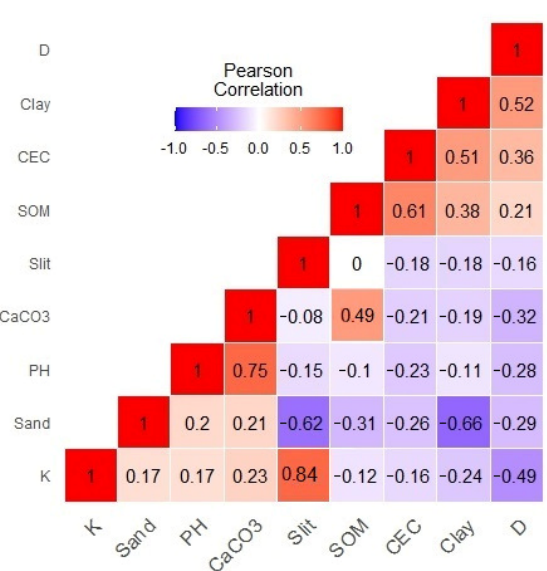
Figure 3. Textural composition of studied soils (USDA texture classification).